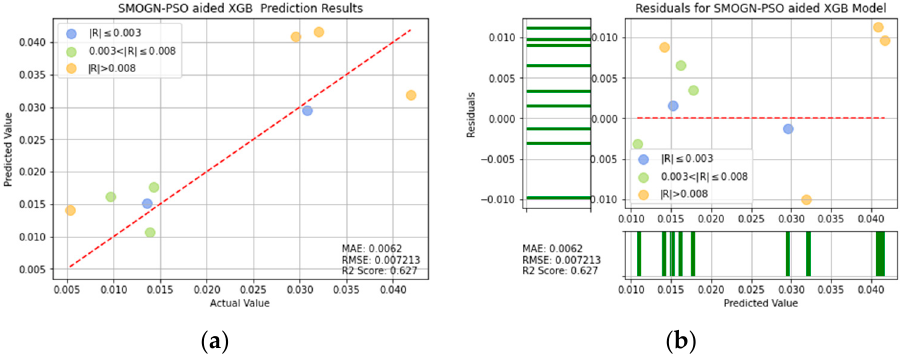
Figure 21. SMOGN-PSO-XGB prediction results: ( a ) comparison of actual and predicted precision values, and ( b ) residual plot.